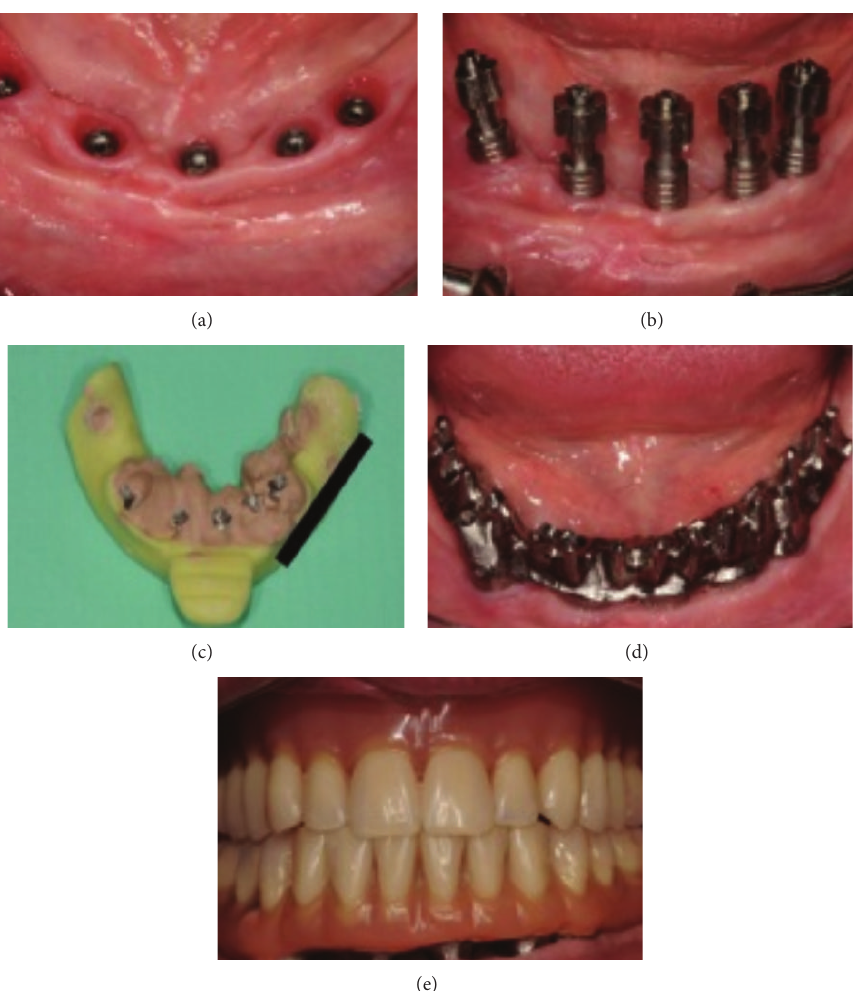
Figure12:Thehealedmucosaandtheosseointegratedimplants(a).Theimpressionabutmentswheretheangulationofthedistalrightimplant is inserted and evident (b). The impression was taken using plaster (c). The try-in of the screwed titanium implant bridge (d). The titanium implant bridge delivered